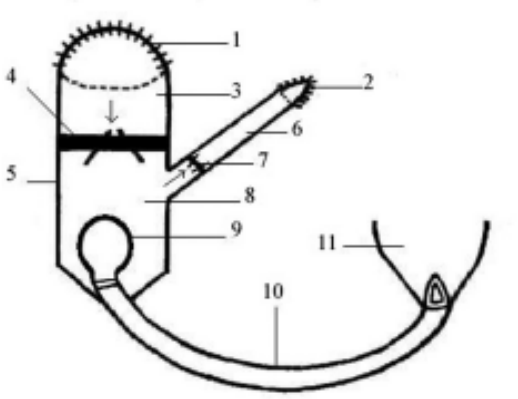
Fig. 1 - Modelo experimental para o ventrículo pulmonar que produz pressão pulsátil. A válvula mecânica de nº 29 (de forma que ela abrirá 2/3 do enxerto) é colocada em um implante Dacron 30 mm de 15 cm de comprimento com sutura contínua de seda 2- 0. Um terço do implante foi anastomosado ao átrio direito